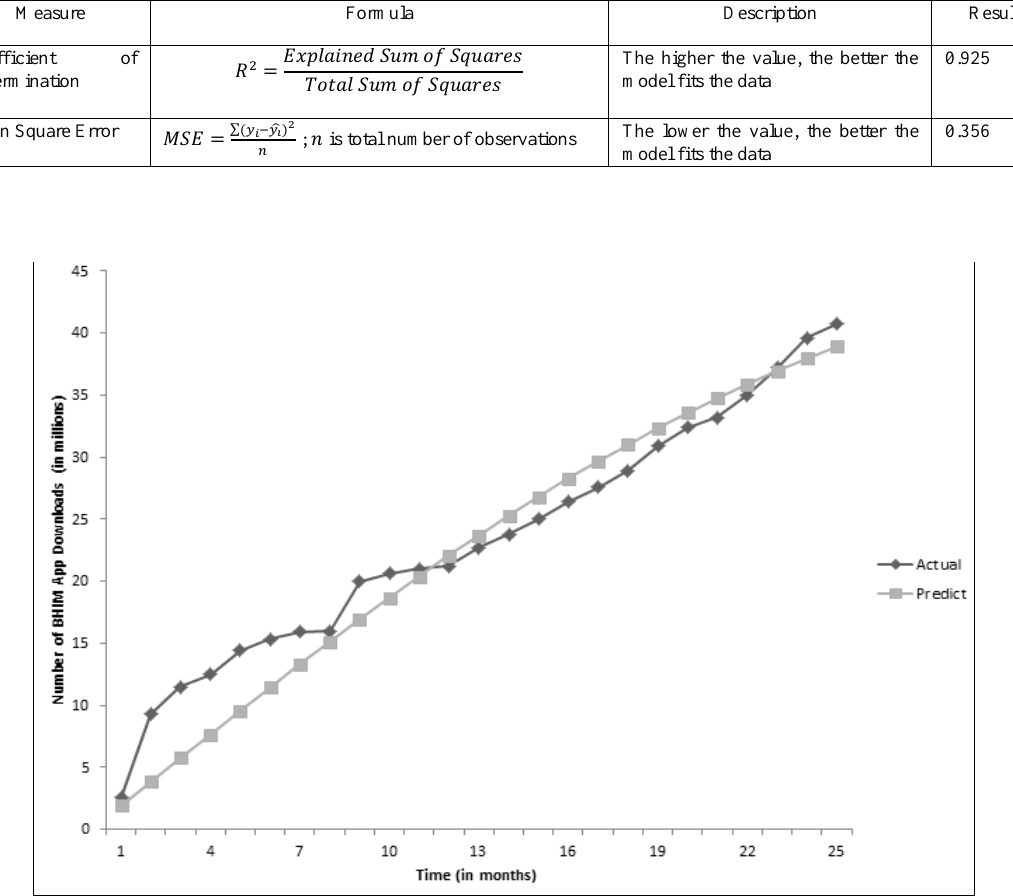
Figure 2. Adoption growth rate for BHIM